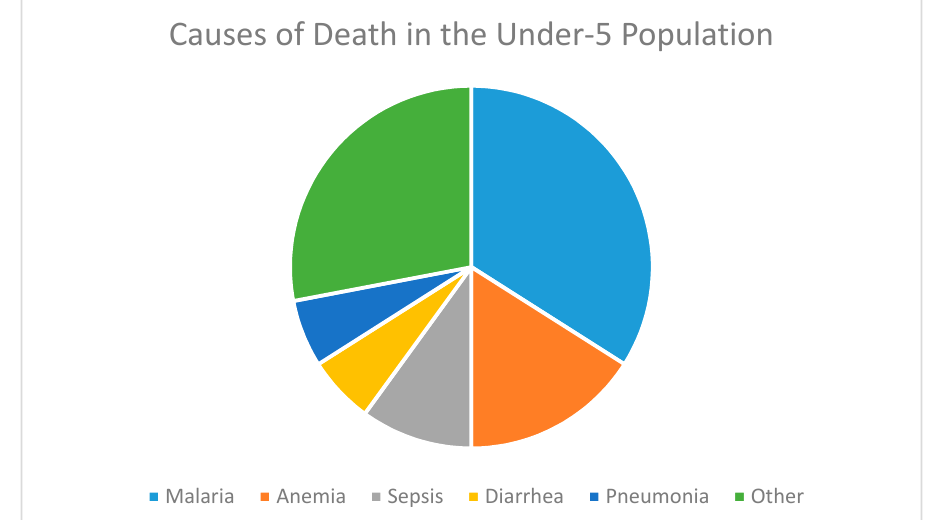
Figure 1. Distribution of diagnoses at death for children under five years of age.